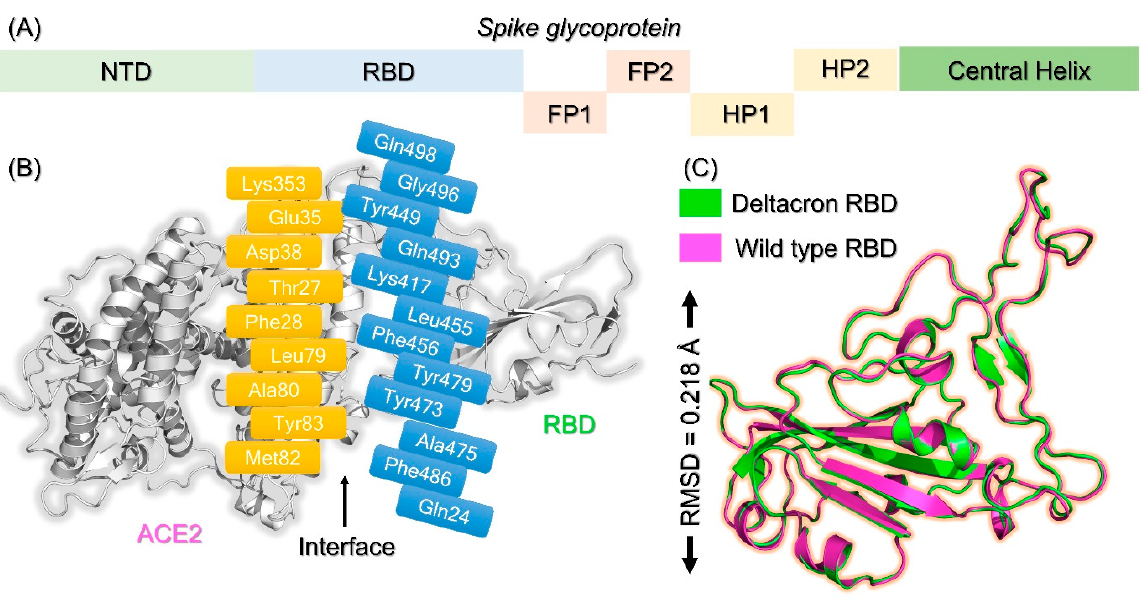
Figure 2. ( A ) Domain organization of the spike protein, ( B ) binding interface, and ( C ) the superim- posed structures of the wild-type and Deltacron RBDs.